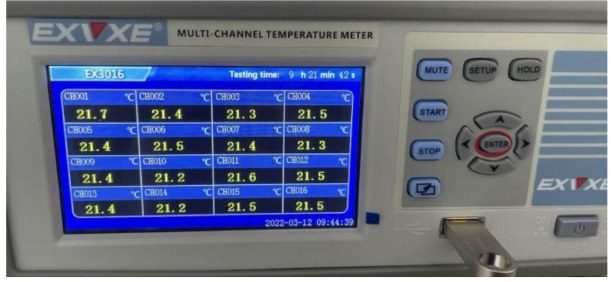
Figure 5. The EXVXE EX3016 multi-channel temperature